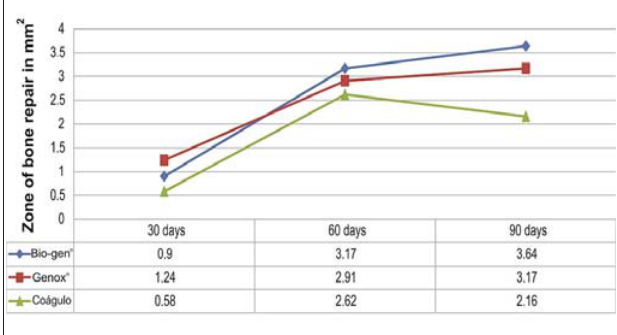
Fig. 4. Mean area of bone formation (mm 2 ) at 30, 60 and 90 days in the alveoli of clot, Genox ® and Bio-gen ®